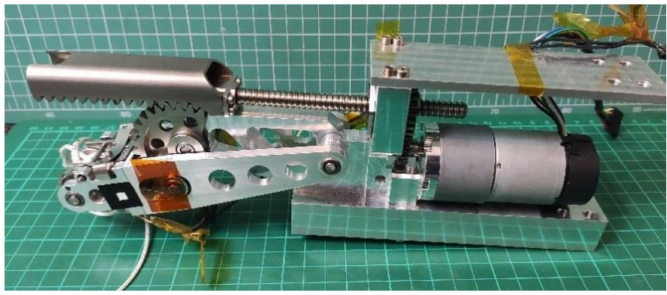
Figure 3. The actual implementation of the actuator in the prototype model (also called BB-0B).